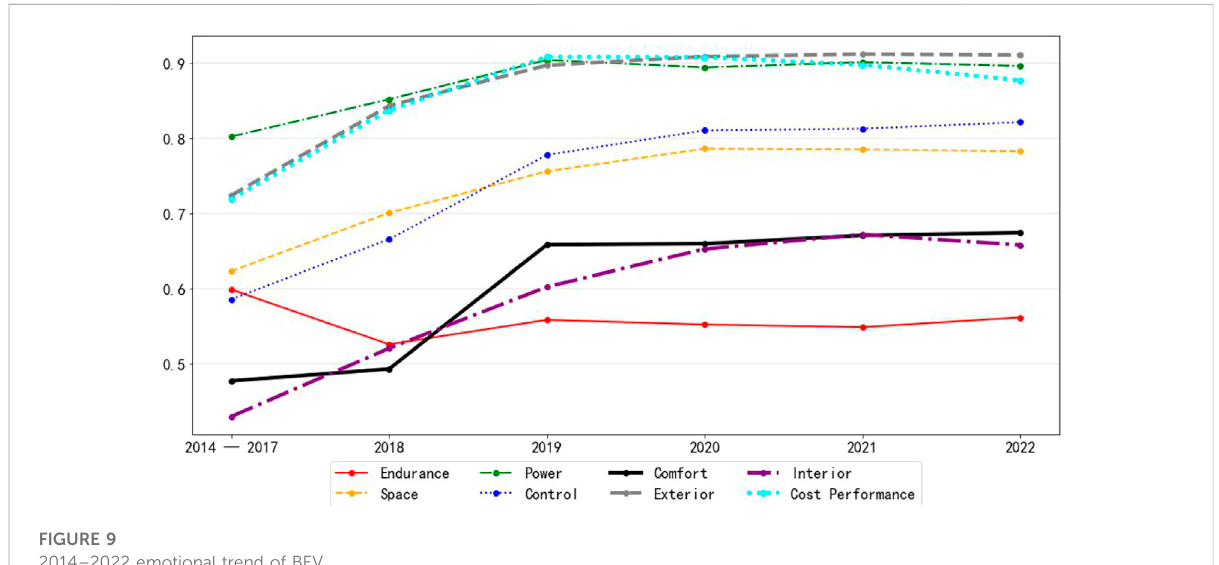
FIGURE 9 2014 – 2022 emotional trend of